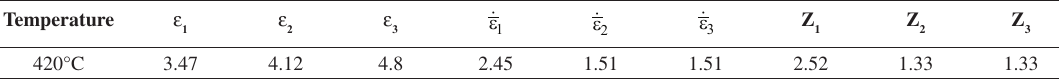
Table 3. Theory Calculation results for dynamic recrystallization during ES process.